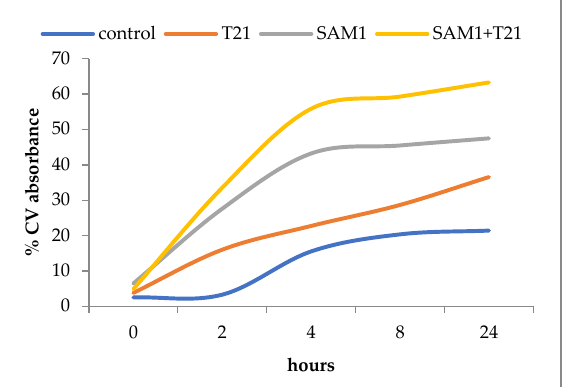
Figure 9. Crystal violet uptake in E. coli ATCC 11229 over 24 h after treatment with T21, SAM1, and SAM1 + T21 (concentration of compounds and combinations: T21 0.5%; SAM1 1MIC; SAM1 1MIC + T21 0.5%).